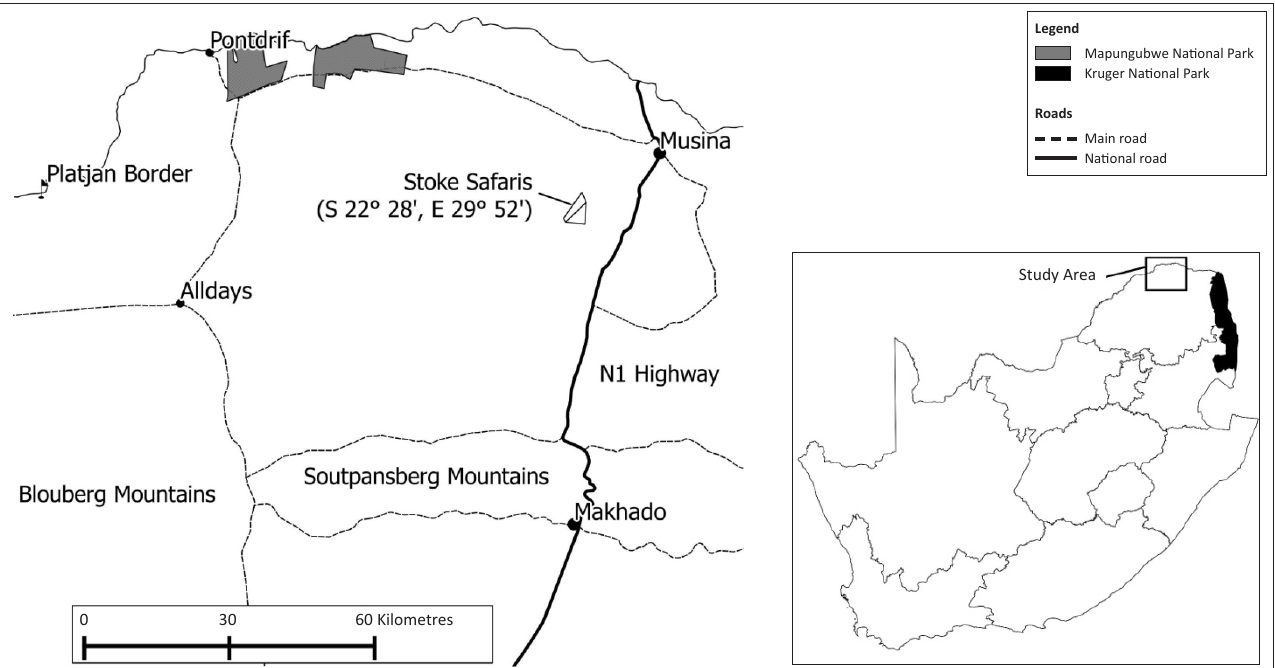
FIGURE 1: Map of the study area in South Africa (inset) with a detailed map of the Limpopo Valley and the location of Stoke Safaris where invertebrate and vegetation data were collected.